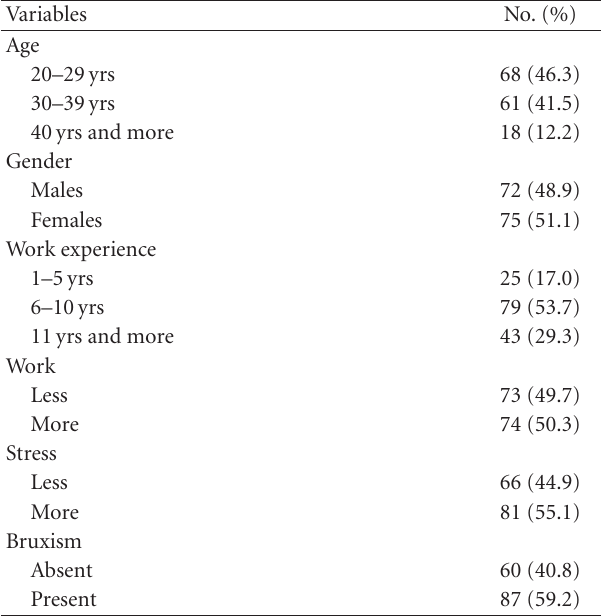
Table 2: Bivariate analysis showing the association of age, gender, work experience, work, and stress with diurnal